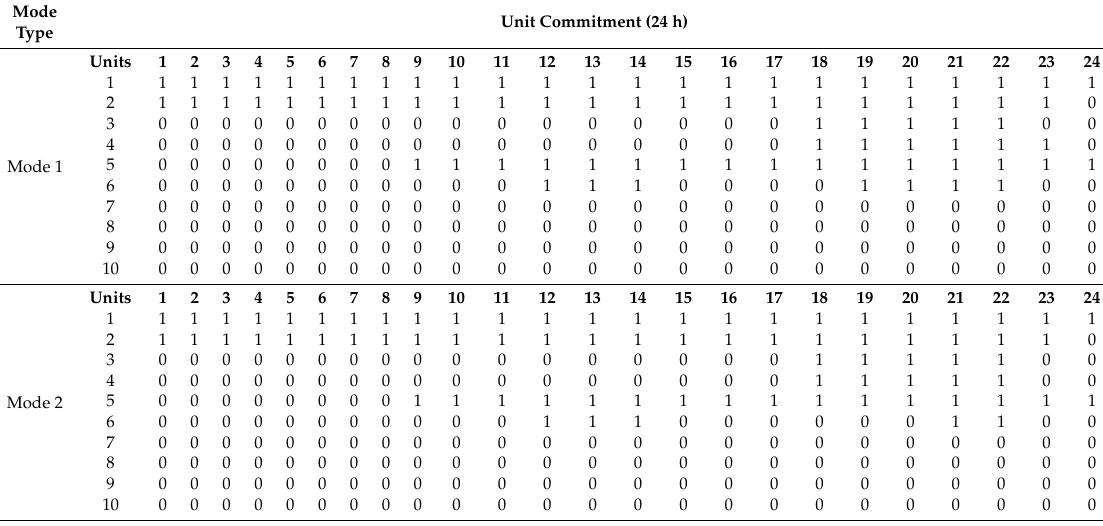
Table 3. Comparison of unit commitment results in two modes.